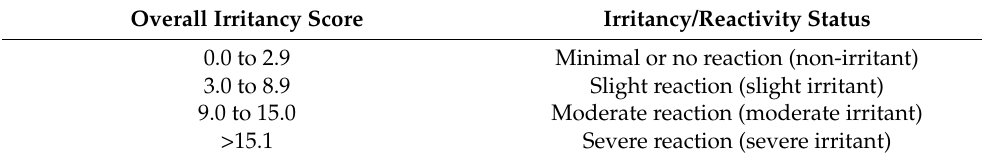
Table 11. Irritancy/Reactivity